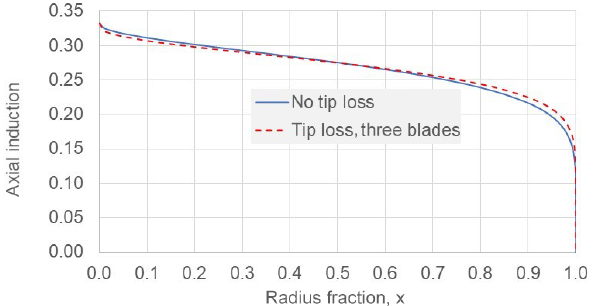
Figure 5. Power gain related to rotor radius expansion ratio.